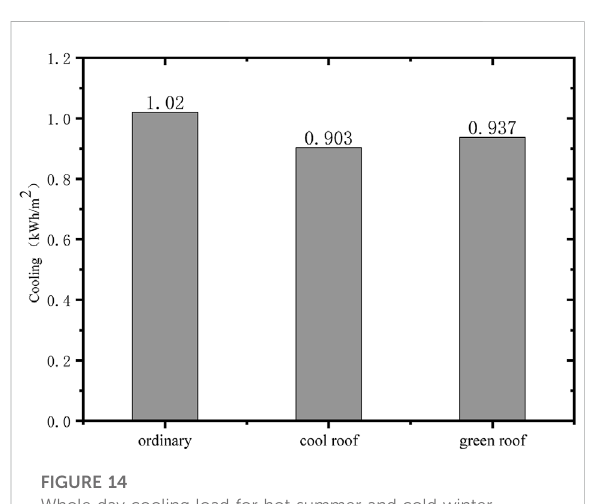
FIGURE 16 Ambient air temperature difference in hot summer and warm winter